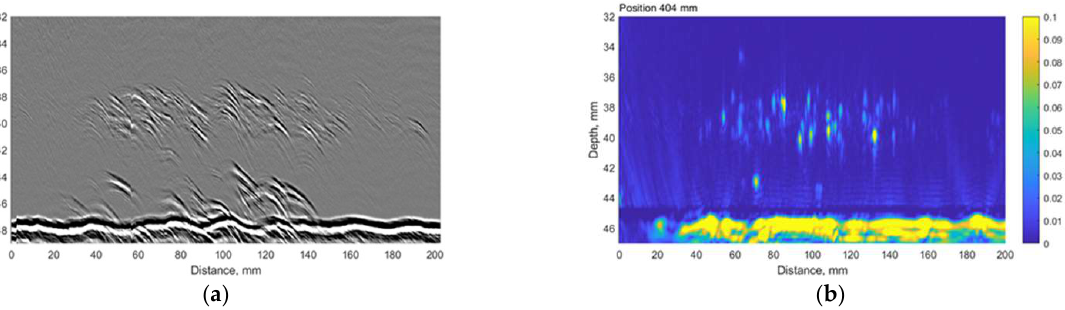
Figure 17. The comparison between ( a ) TULA and ( b ) TFM measurements at 404 mm circumferen- tial scan position. Vertical colour bar represents the peak-to-peak amplitude in arbitrary units.